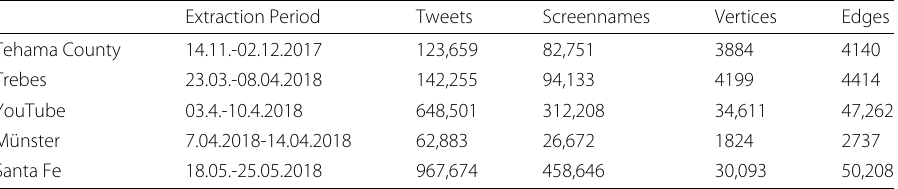
Table 1 Basic information about each event (data extraction period, number of tweets, and number of screennames) and our derived communication network (number of vertices and edges) Extraction Period Tweets Screennames Vertices Edges Tehama County